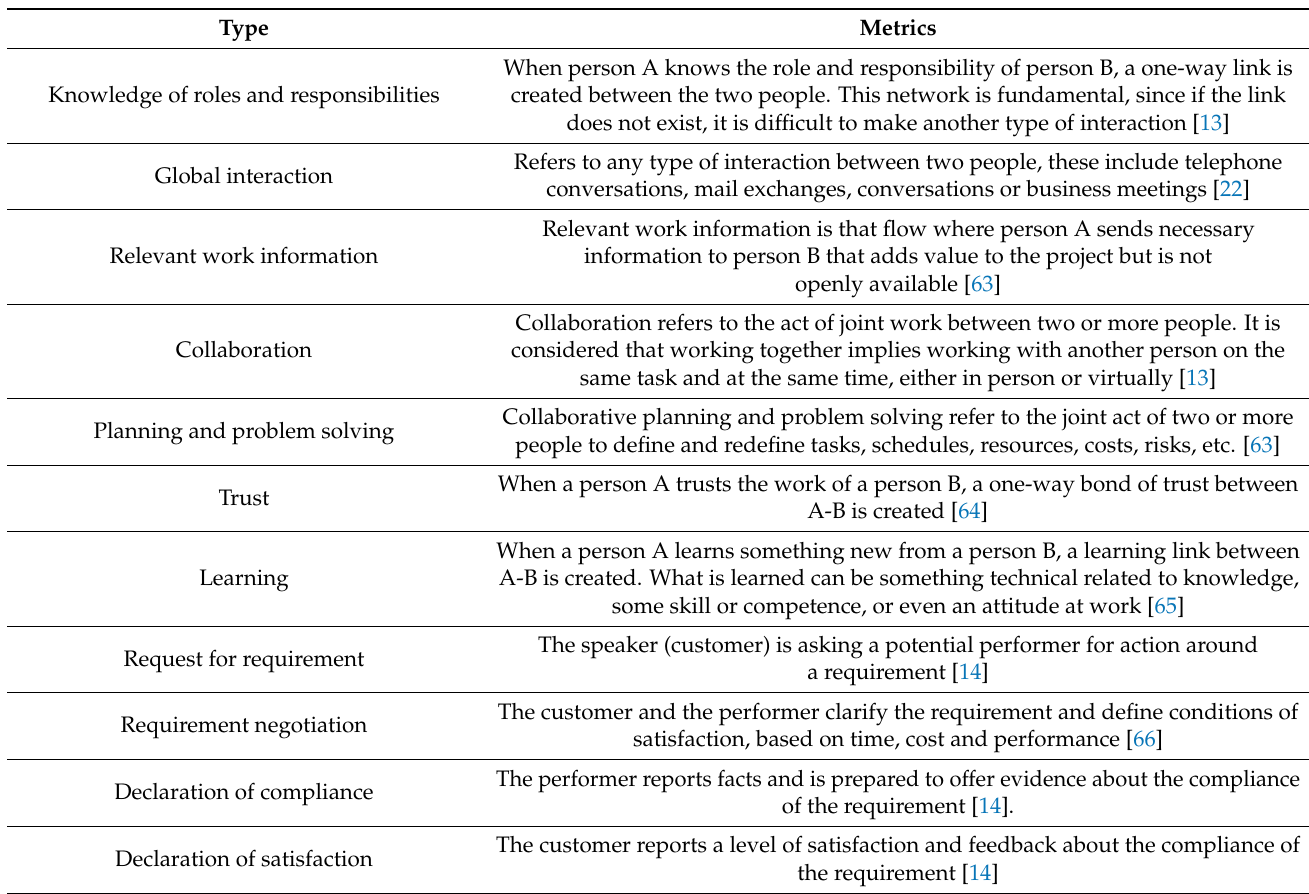
Table 3. Description of type of